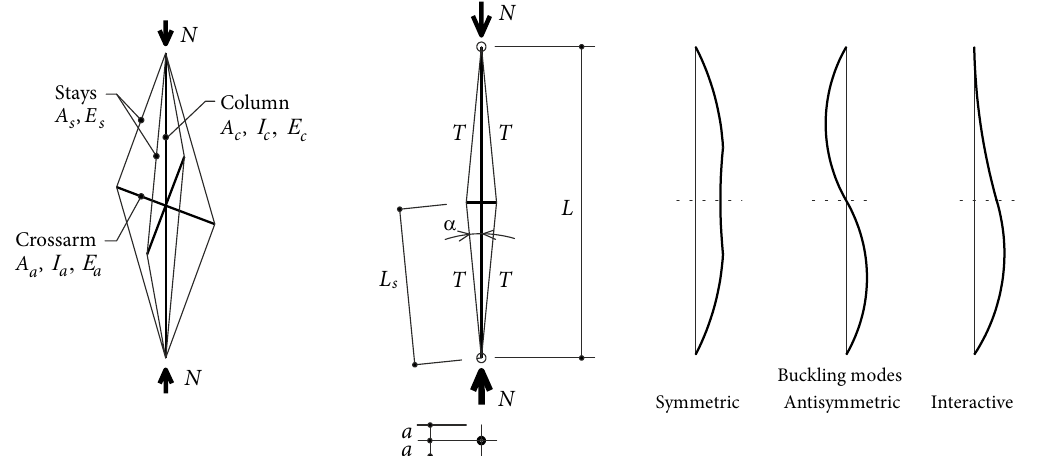
Fig. 2. Stayed column in basic set-up (left), geometry of analysis (right)